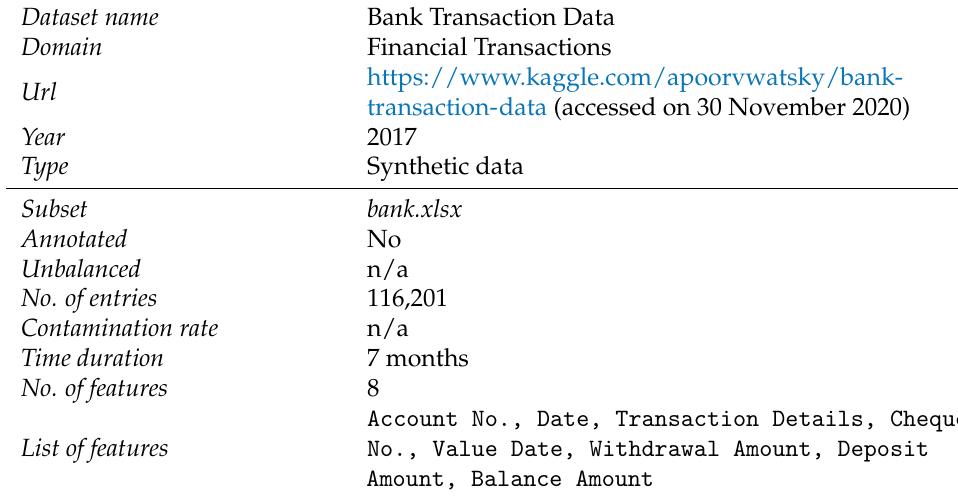
Table 7. Bank Transaction Data dataset